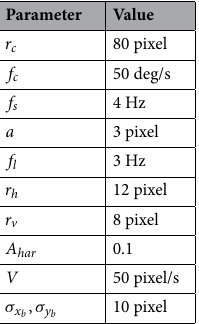
Table 6. Simulation parameters used for tracking assessment.